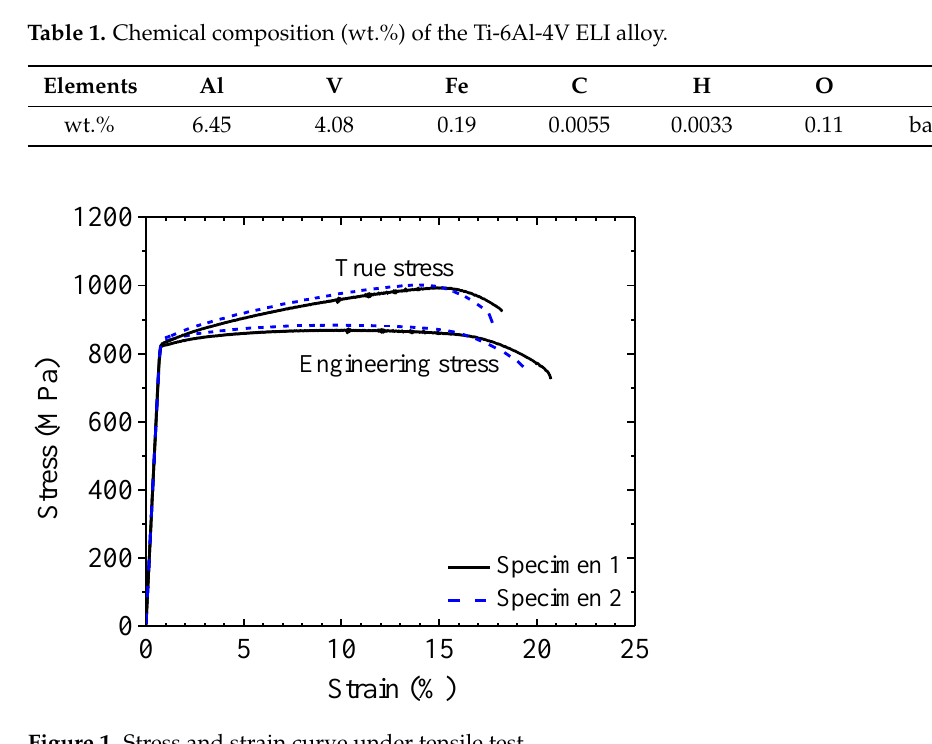
Figure 1. Stress and strain curve under tensile test.